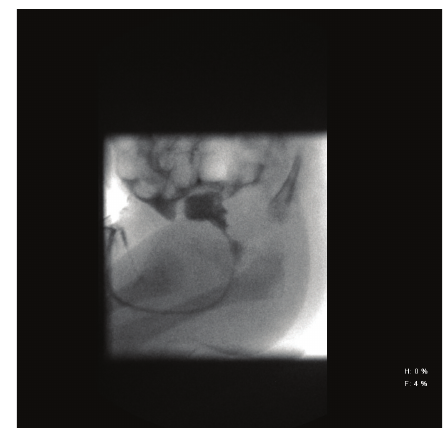
Figure 3: Water-soluble contrast administered via indwelling transurethral catheter. Spontaneous micturition on early filling (approximately 5 mL injected), with immediate extravasation of contrast into the peritoneal cavity. The study was therefore termi- nated, before the posterior urethra could be adequately evaluated. Bladder rupture is